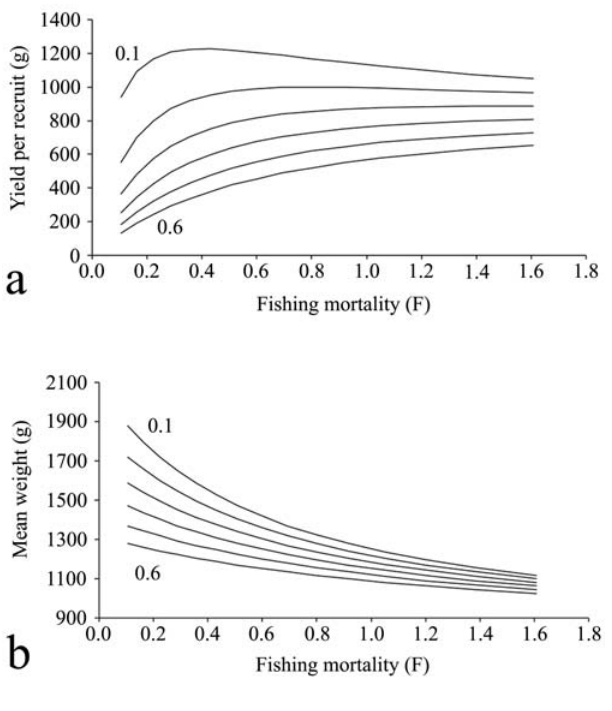
Fig. 4. (a) Simulation of the yield per recruit (g) in different scenarios of fishing mortality (year -1 ). Each curve represents a natural mortality rate (year -1 ) (0.1 to 0.6 with intervals of 0.1) for S. brasiliensis in the area of influence of Corumbá Reservoir. (b) Simulation of the average weight (g) in different scenarios of fishing mortality (year -1 ). Each curve represents a natural mortality rate (year -1 ) (0.1 to 0.6 with intervals of 0.1) for S. brasiliensis in the area of influence of Corumbá Reservoir.